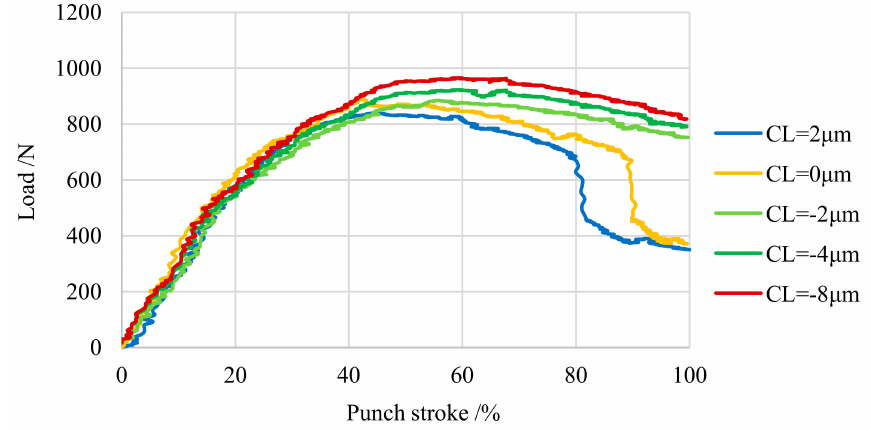
Figure 5. Load–stroke curves for various